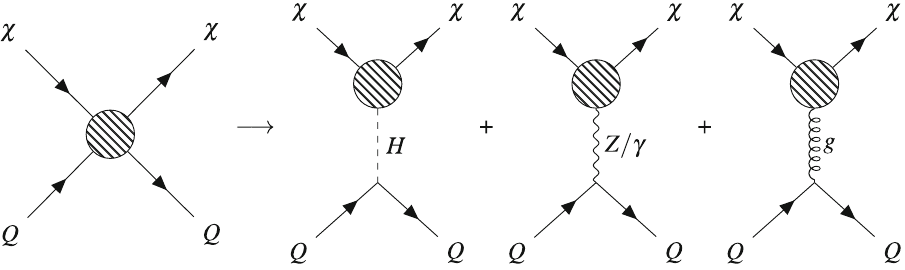
Fig. 2 Several t -channel diagrams contributing to the DM-nucleon cross